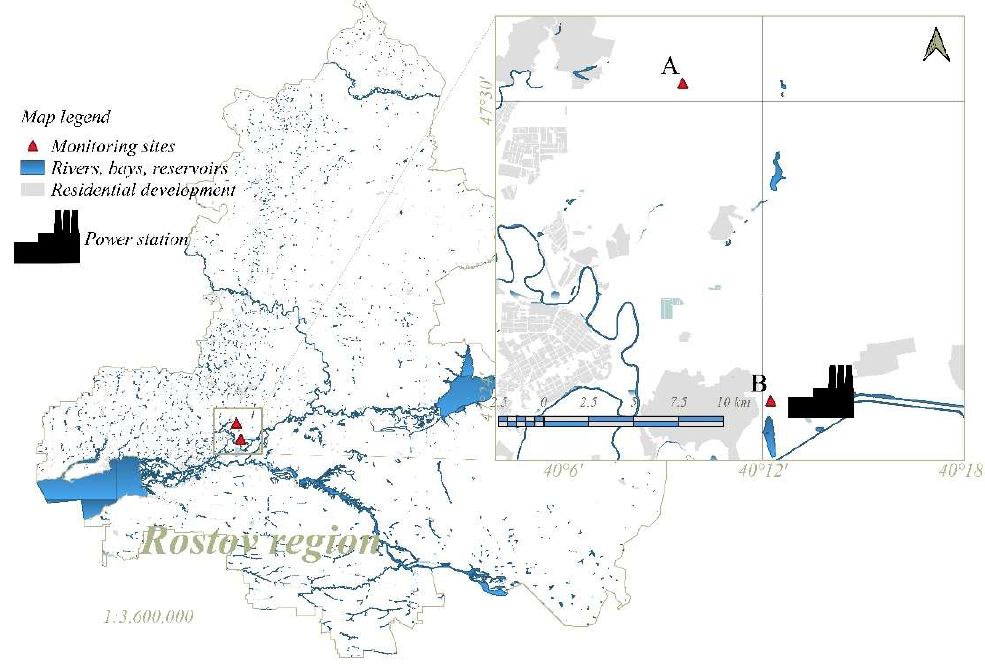
Figure 1. Overview of map showing location of the two sites for sampling.